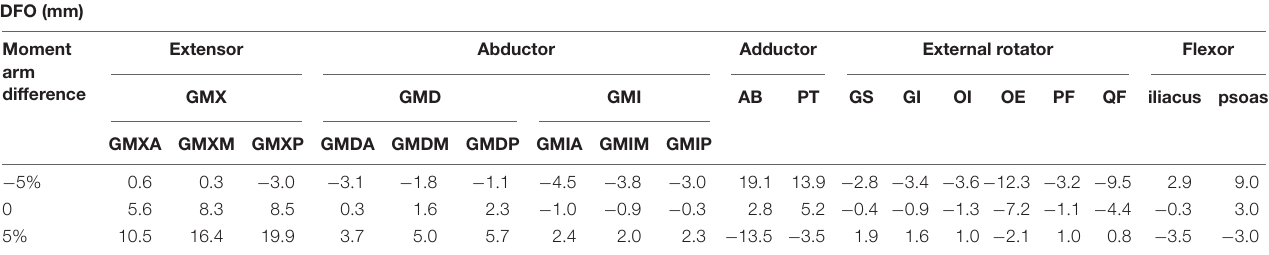
TABLE 3 | The FO difference based on the linear regression curve at different normalized muscle moment arm differences of extensor, abductor, adductor, external rotator and flexor. DFO (mm) Moment Extensor Abductor Adductor External rotator arm difference